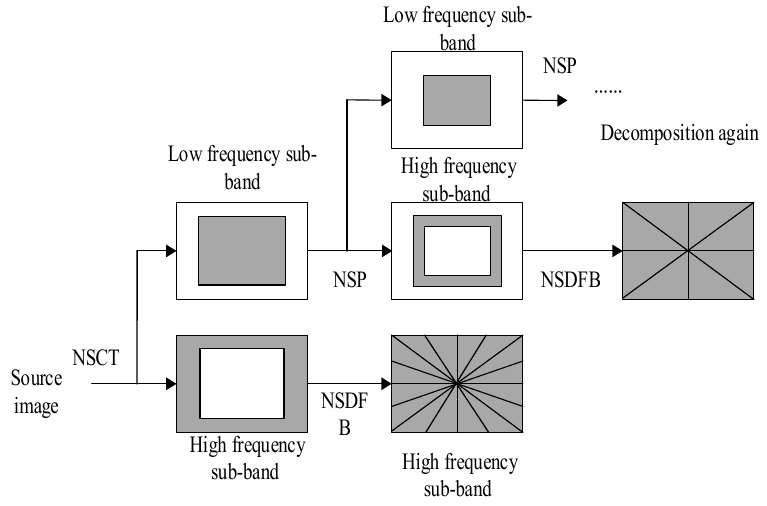
Figure 2. Decomposition of non-subsampled contourlet transform (NSCT).